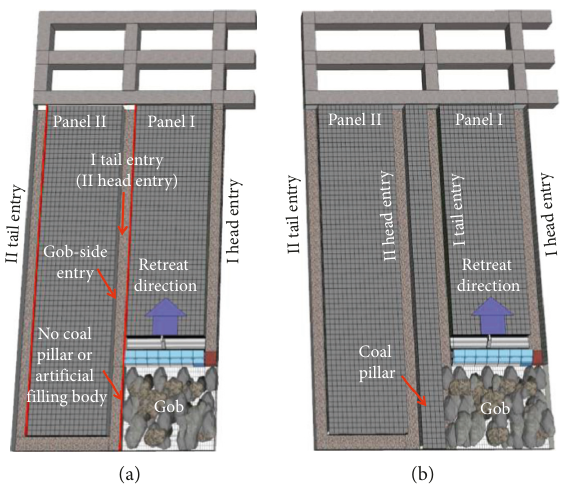
Figure 1: Comparison of the two underground coal mining schemes: (a) FRME approach; (b) small-pillar